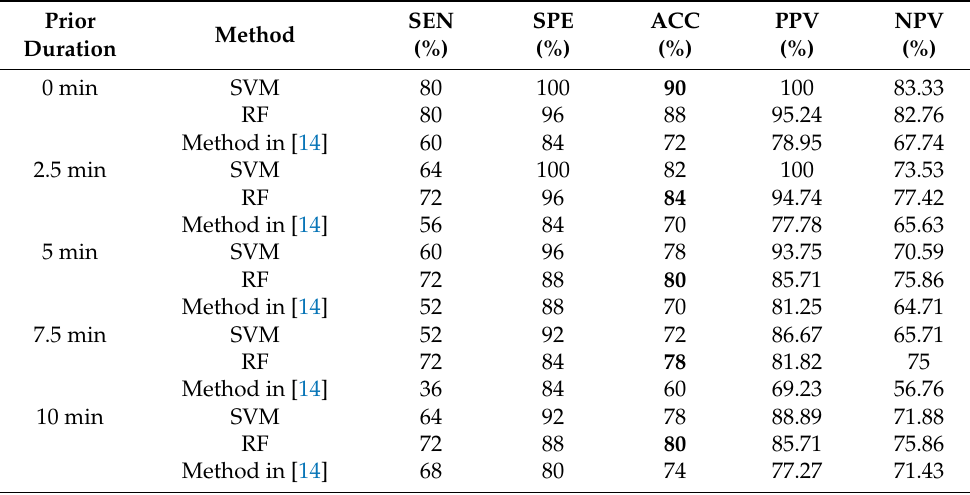
Table 9. Confusion matrix on the test data (7.5 min before